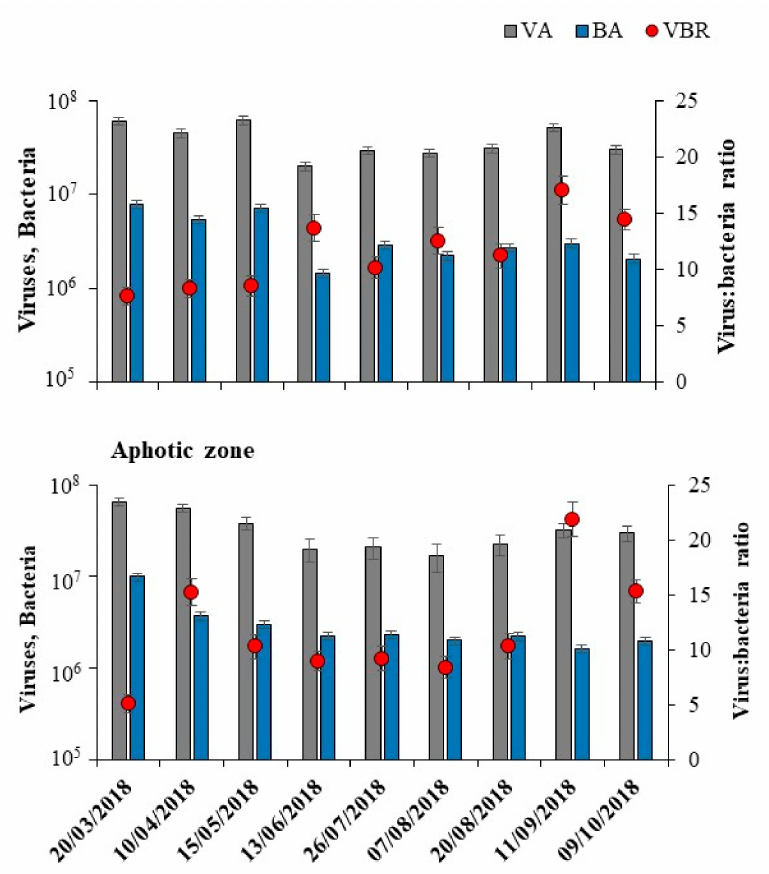
Figure 1. Time series variations in the abundance of viruses (VA; grey bars), bacteria (BA; blue bars) and their ratio (VBR; red dots; right y axis) at sampled depths in Lake Goule. Data represent mean ± SE ( n =